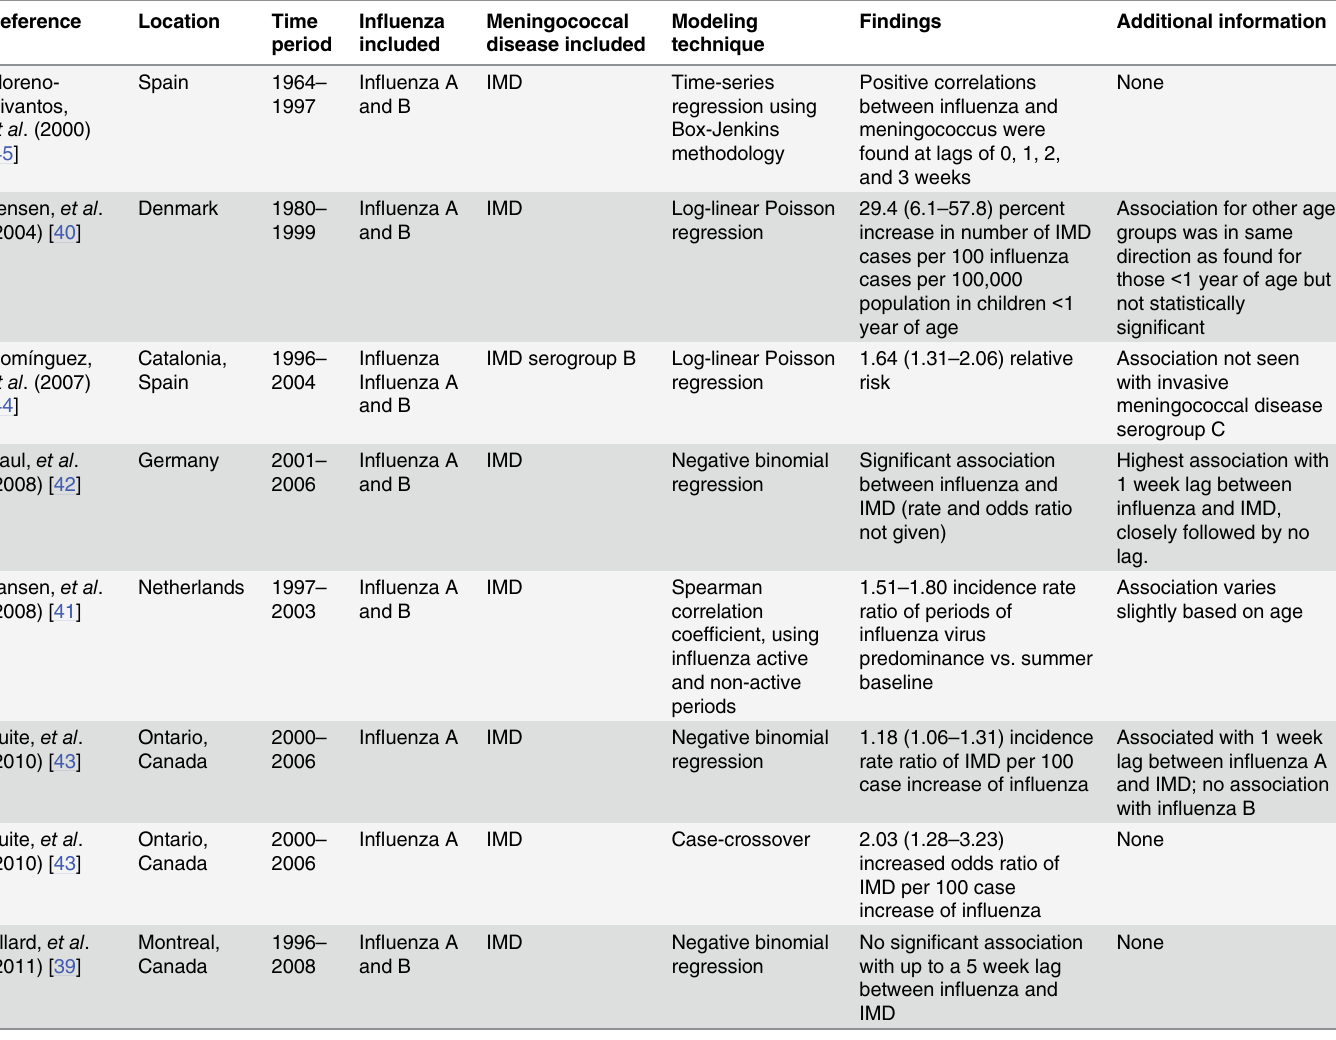
Table 1. Summary of ecologic modelling studies evaluating the association between influenza and invasive meningococcal disease